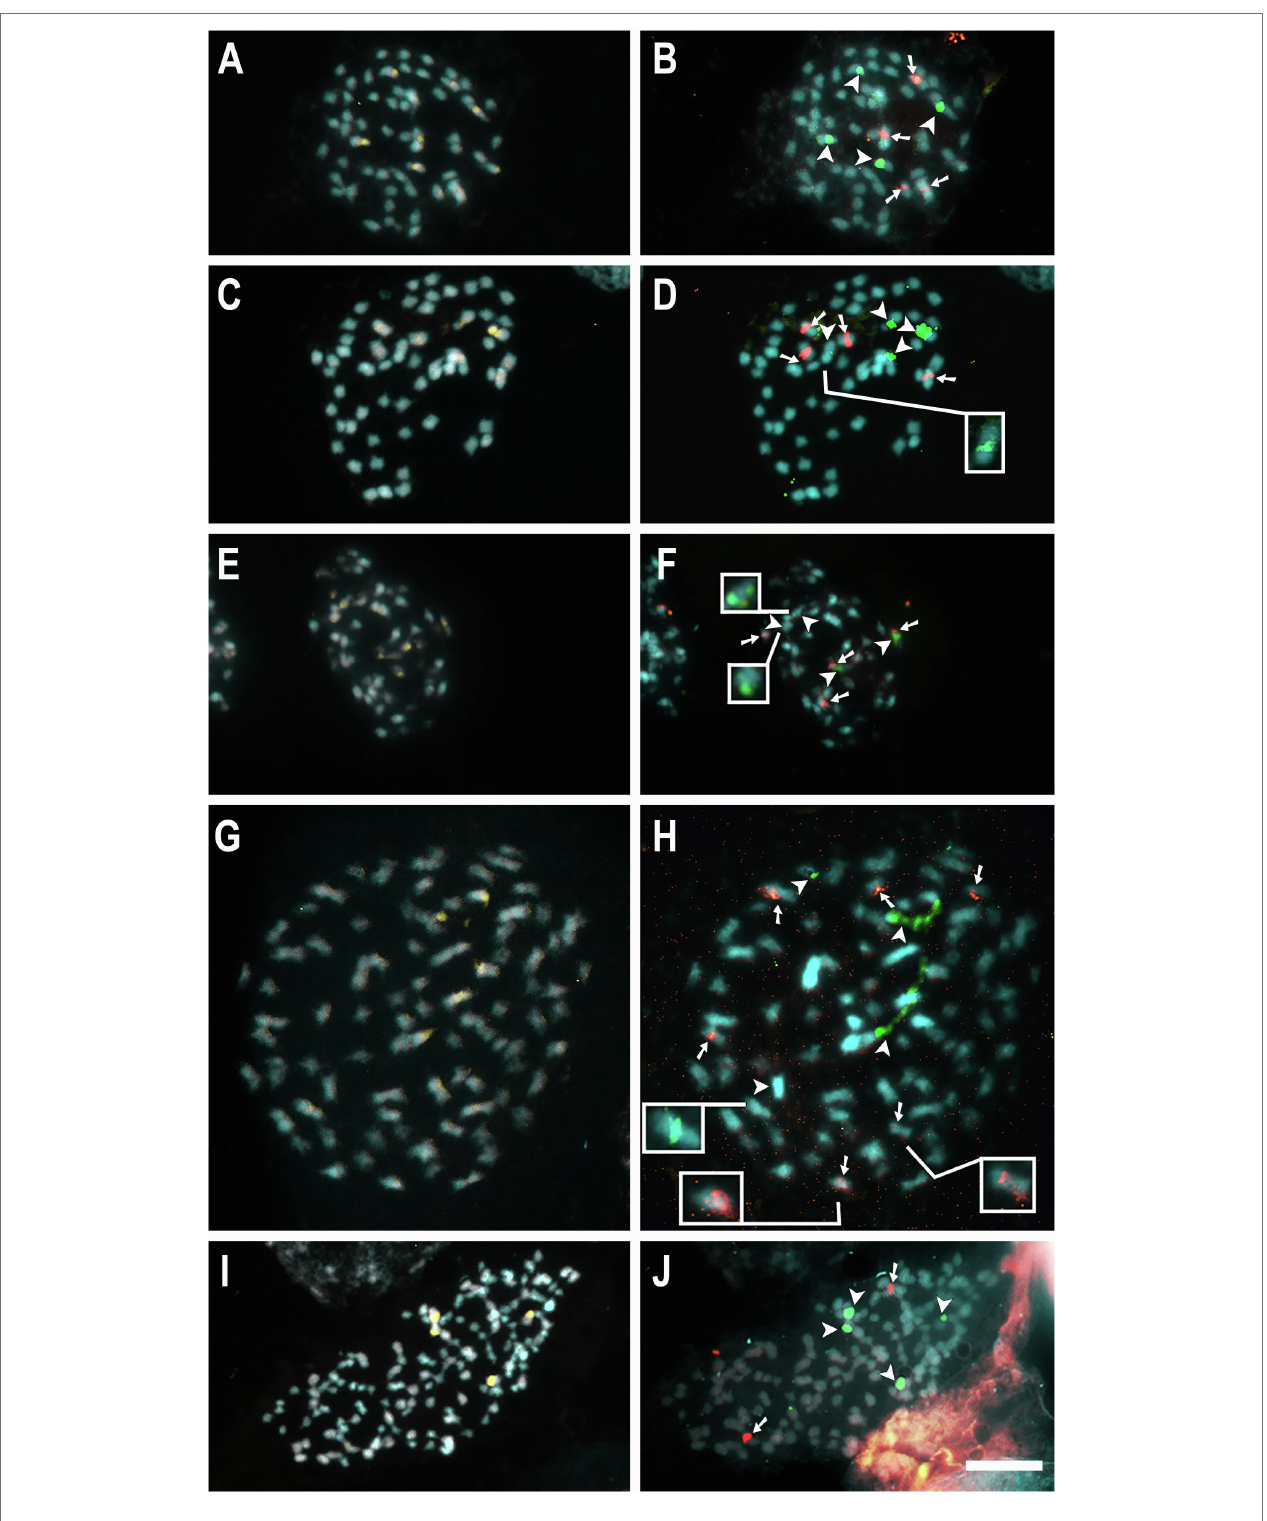
FIGURE 2 | Mitotic metaphases of the polyploids C. campestris 2 n = 56 (A,B) , C. racemosa 2 n = 60 (C,D) , C. psorothamnensis 2 n = 60 (E,F) , C. globosa 2 n = 90 (G,H) , and C. sandwichiana 2 n = 150 (I,J) stained with CMA (yellow) and DAPI (blue) in A, C, E, G, and I , and with FISH of 5S (red) and 35S (green) rDNA in B, D, F, H, and J . Arrowheads indicate 35S (green) and arrows indicate 5S (red) rDNA sites. Insets show weak signals in higher contrast. Bar in J represents 10 μ